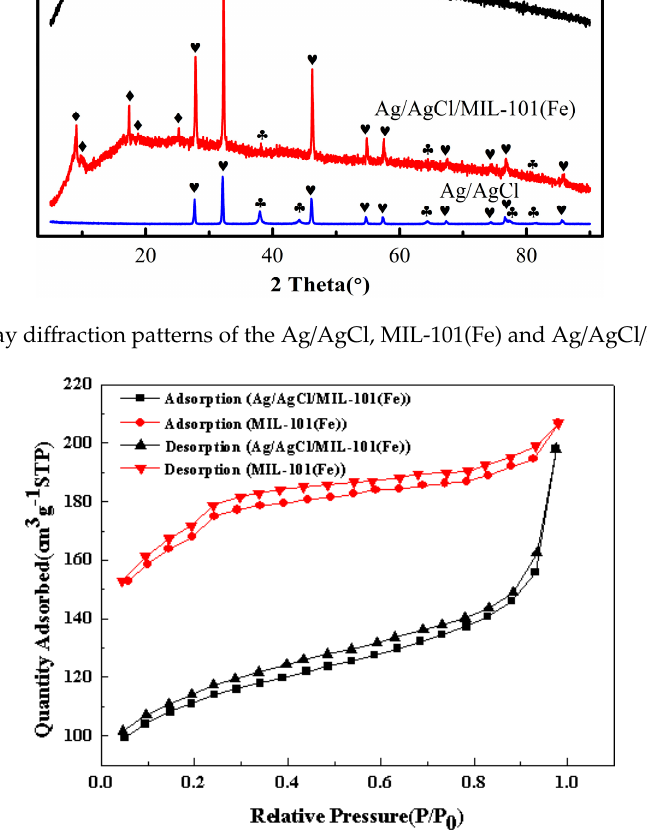
Figure 2. Nitrogen adsorption ‐ desorption isotherms of MIL ‐ 101(Fe) and Ag/AgCl/MIL ‐ 101(Fe).